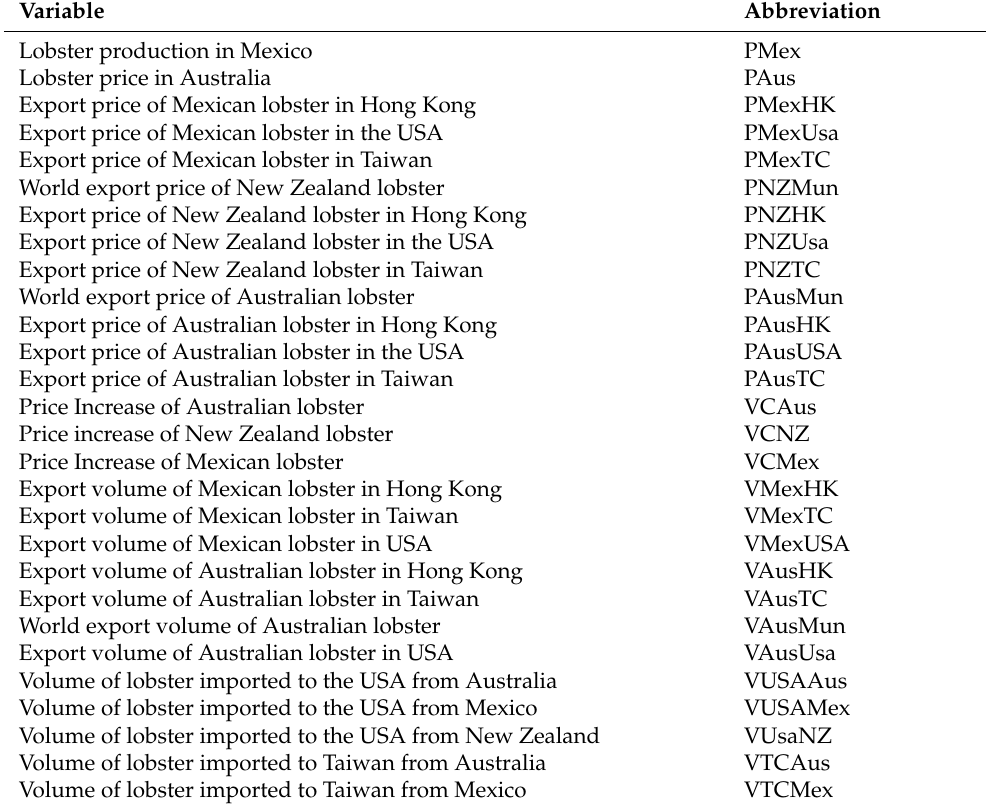
Table 1. Exogenous variables affecting Mexican lobster prices. Data are monthly figures for the years 2006 to 2018 (Sources: